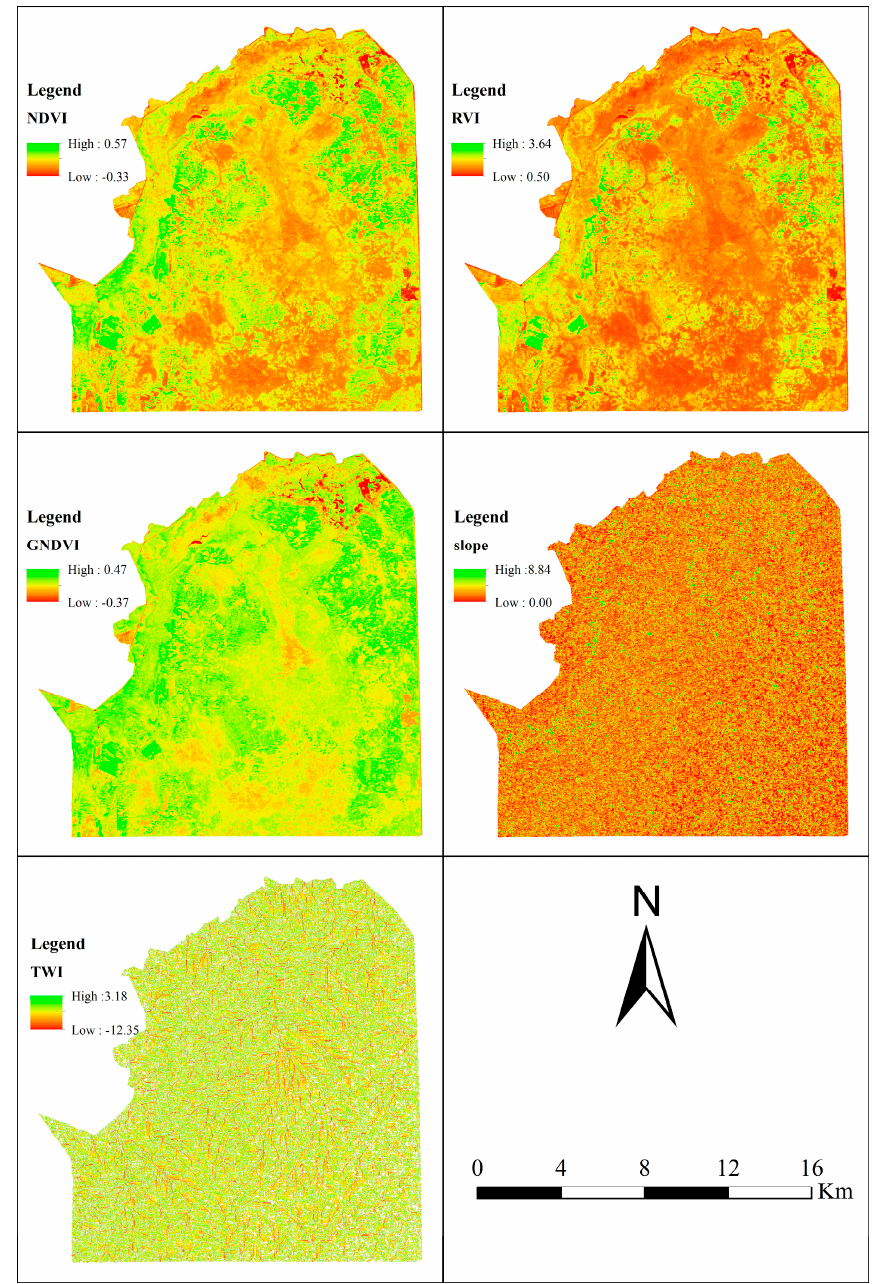
Figure A1. Several variables for ZY-3 data that performed better in variable selection.